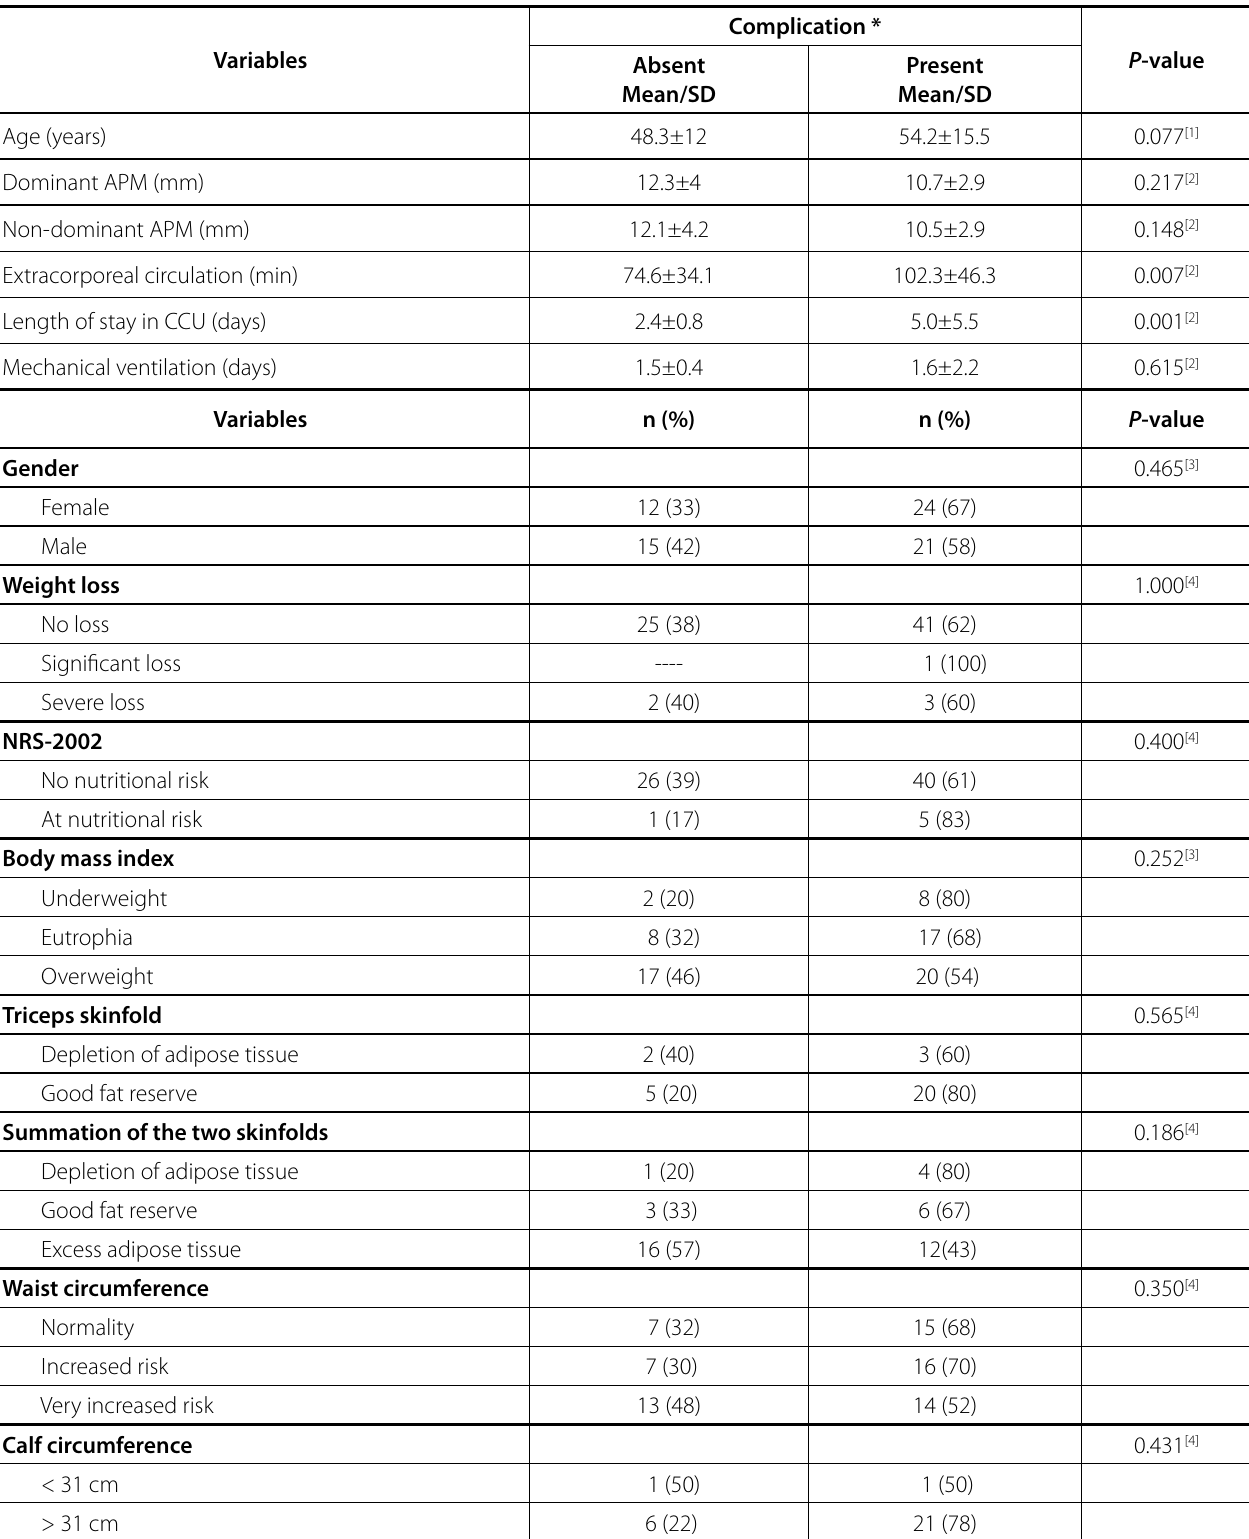
Table 3. Association between anthropometric and transoperative variables and the occurrence of postoperative complications in individuals undergoing major elective cardiac